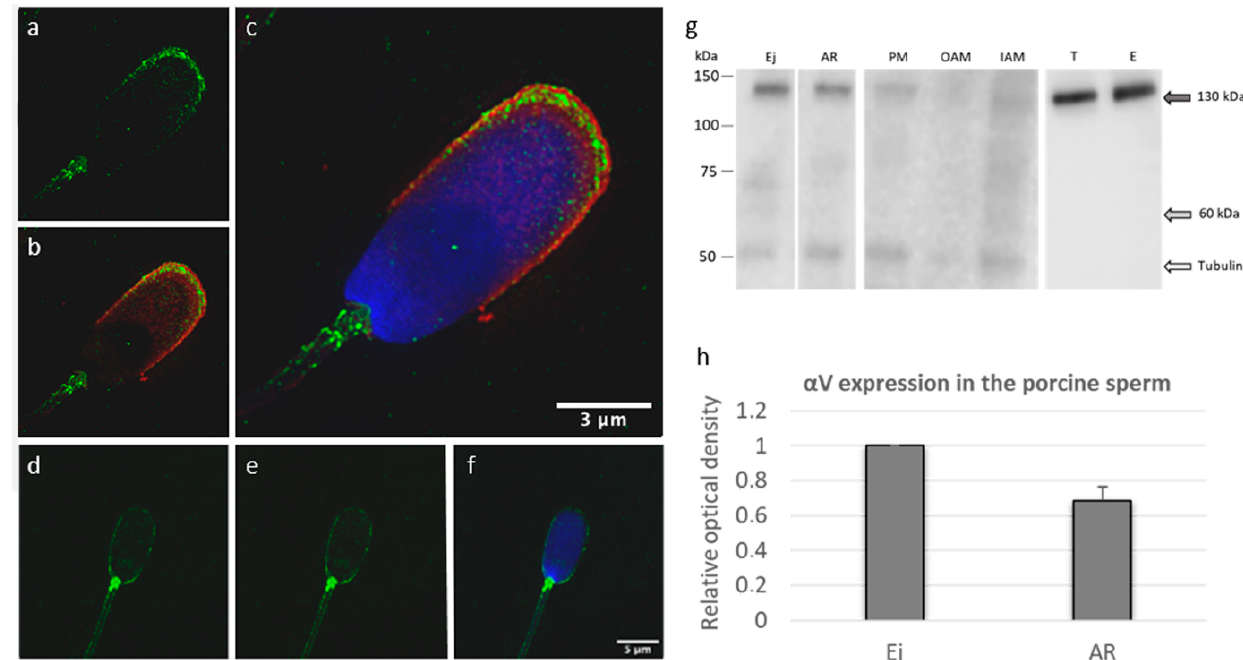
Figure 4. Detection of α V integrin in porcine sperm and reproductive tissues. ( a–c ) The α V integrin (green) localization on acrosome-intact ejaculated sperm was visualized by SIM and confined to the PM covering the acrosomal region and acrosomal membranes with enrichment in OAM. ( d–f ) The α V integrin (green) localization after the acrosome reaction was captured by confocal microscopy and observed in IAM and the PM covering the post-acrosomal segment, with neck enrichment. Acrosomal status was visualized with PNA staining (red); Hoechst (blue) was used for detection of the nucleus. Scale bars represent 3 µM ( a–c ) and 5 µM ( d–f ). ( g ) Western blot immunodetection of α V integrin using protein extracts from the ejaculated sperm (Ej), acrosome-reacted sperm (AR), PM, OAM, and IAM fractions from ejaculated sperm, testis (T), and epididymis (E). Antibody detected bands show protein of 130 kDa size (gray arrow). ( h ) Western blot densitometry analysis of α V integrin expression in ejaculated (Ej) and acrosome-reacted (AR) sperm normalized to the amount of tubulin shows a visible α V integrin decrease ( p > 0.05) in AR sperm.